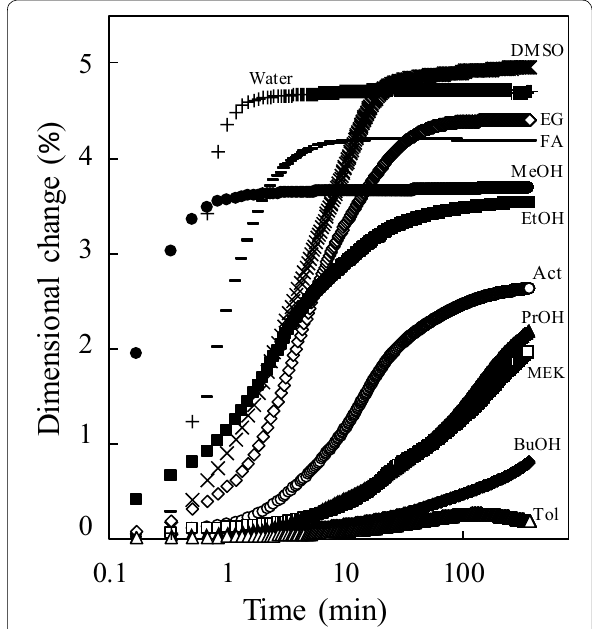
Fig. 6 Change in the dimension of the untreated sample after soaking in water or each organic